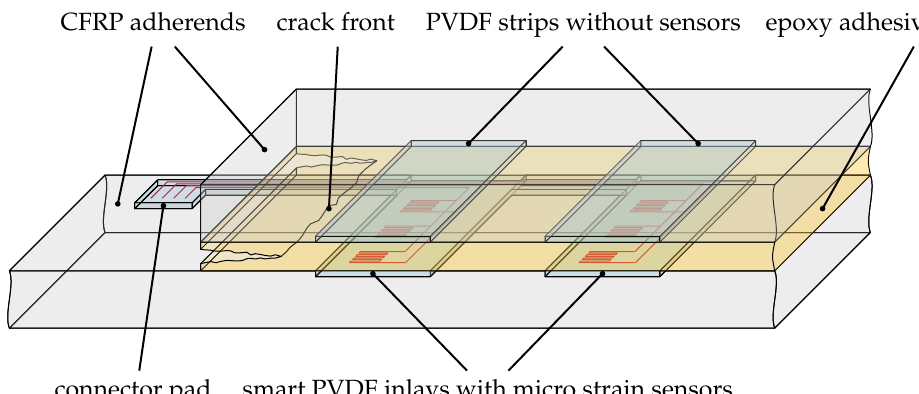
Figure 1. Sketch of the multifunctional disbond arrest feature (MDAF). Polymer strips carrying strain sensors are integrated into the lower adherend and paired with plain strips of the same material with equal width and thickness in the upper adherend. To simplify integration and contacting, the sensor strips are combined by a slender sideways link into an F-shape geometry forming a smart inlay.